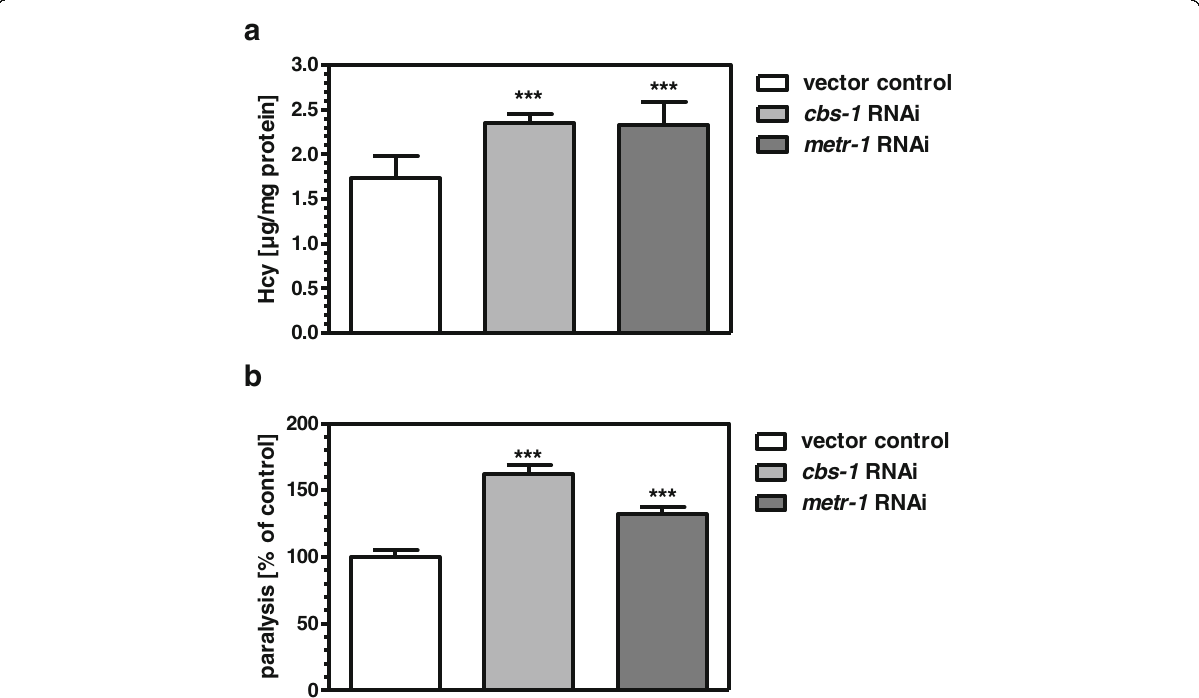
Fig. 1 Knockdown of cbs-1 and metr-1 via RNAi increase Hcy level and paralysis rate in CL2006. Hcy concentration was determined with the Human Hcy-ELISA Kit 48 h after nematodes had reached the young adult stage ( a ). At the same, stage paralysis in CL2006 was assessed subsequent to a heat- shock for 1.5 h at 35 °C by tapping the nematodes with a bent platinum wire and subsequent scoring of their moving ability ( b ). *** p <0.001 versus the vector